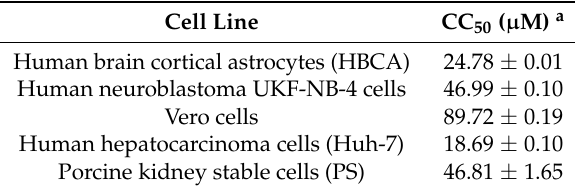
Table 1. Cytotoxicity of arbidol for various cell lines of neurone or extraneural